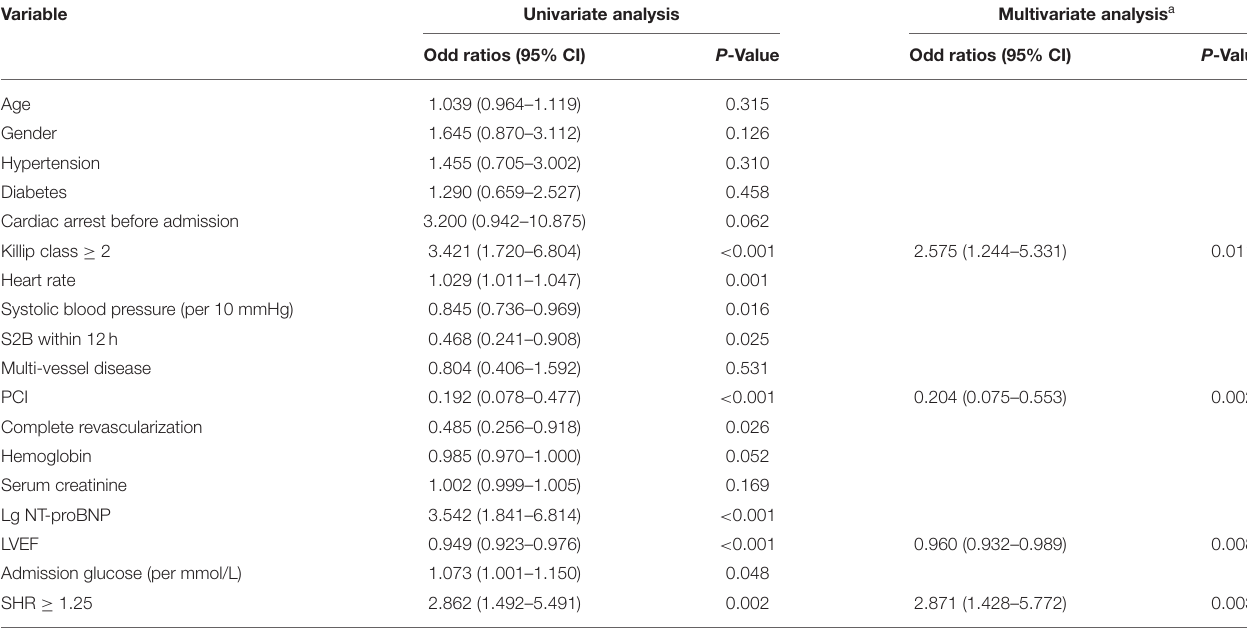
TABLE 4 | Univariate and multivariate logistic regression analysis for in-hospital death.